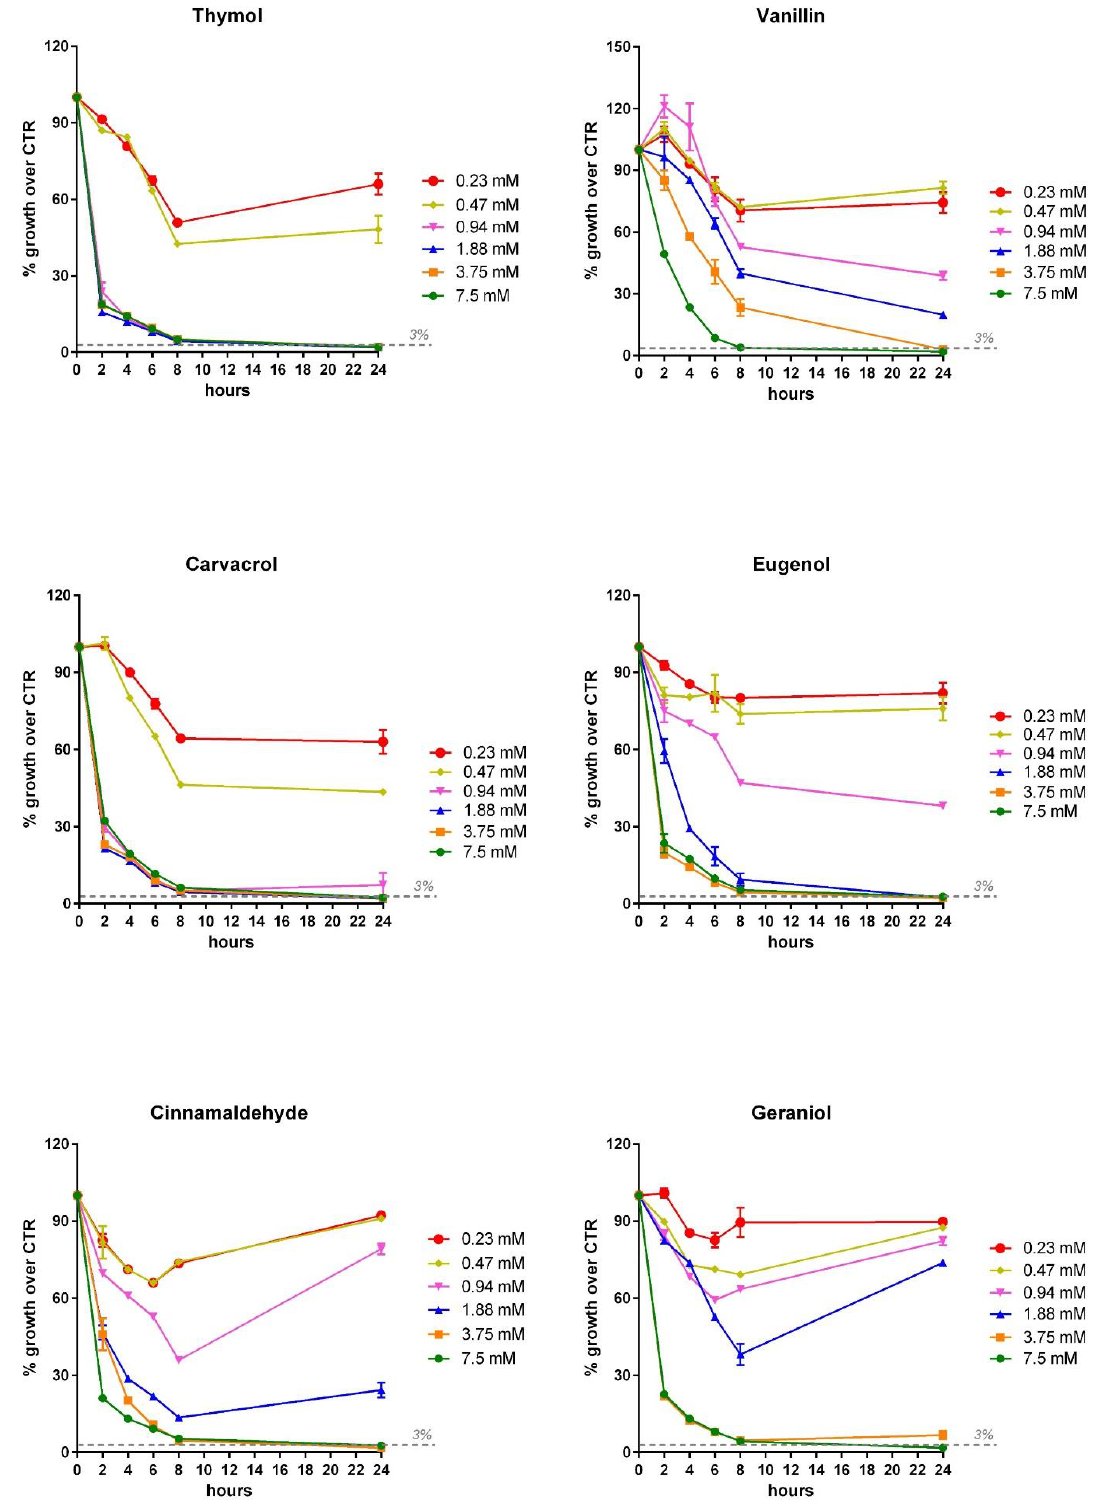
Figure 7. Inhibition dose–response growth of V. anguillarum strain following 2, 4, 6, 8 and 24 h of incubation with the different OA and NIC that showed MIC values at 24 h. V. anguillarum growth is expressed as a percentage of growth relative to control strain and values are presented as the mean ± SEM ( n = 3). Each concentration of OA or NIC is represented with a different color, as shown in the legend close to each graph.